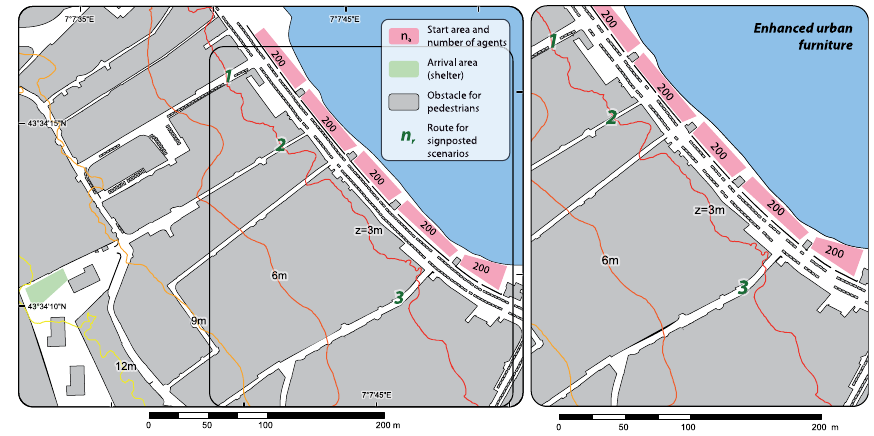
Fig. 6. Location of the sources, destination and enforced routes for pedestrians in both current and enhanced urban environment.